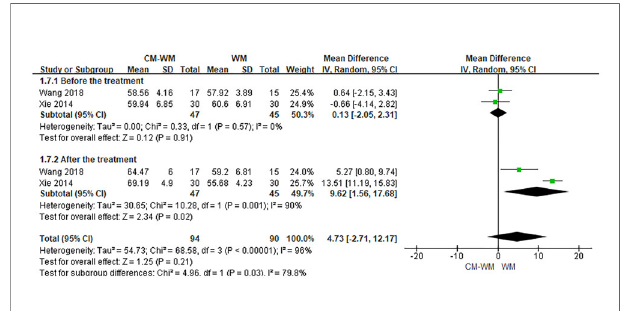
FIGURE 9 | Meta-analyses on CD3.